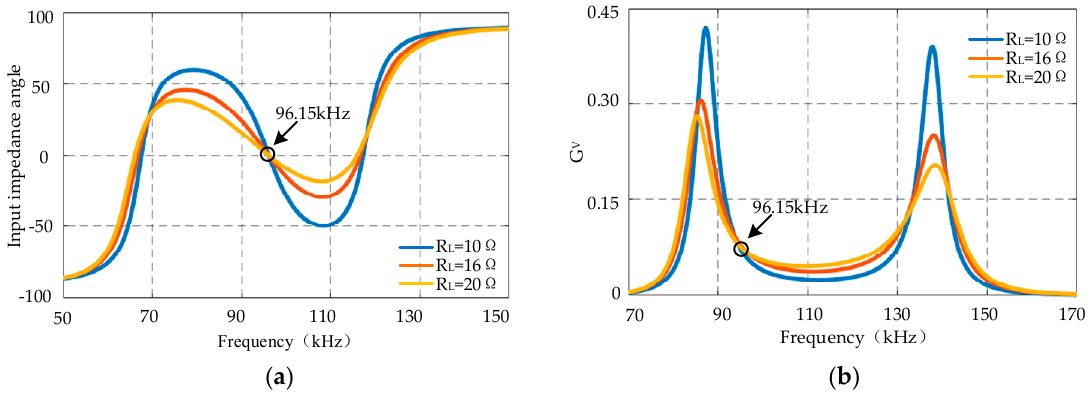
Figure 7. Frequency characteristics of IPT system under different loads. ( a ) Input impedance angle variation with frequency; ( b ) G V variation with frequency.